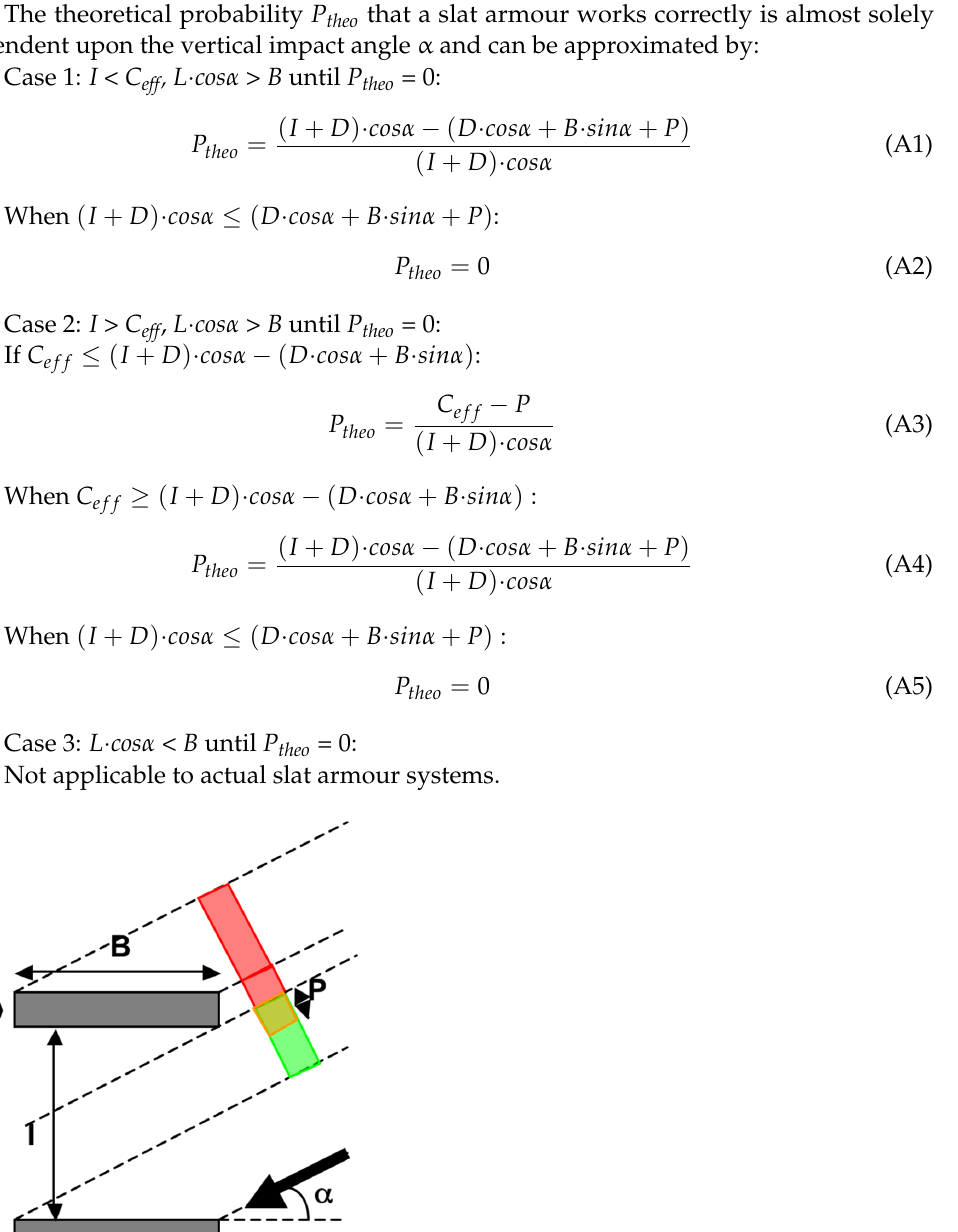
Figure A2. Geometric analysis for the lamellar slat armour system. Red indicating complete im- pact of the fuze on the slat armour, orange grazing of the fuze on the slat armout, green correct functioning of the armour (same applies to following figures).